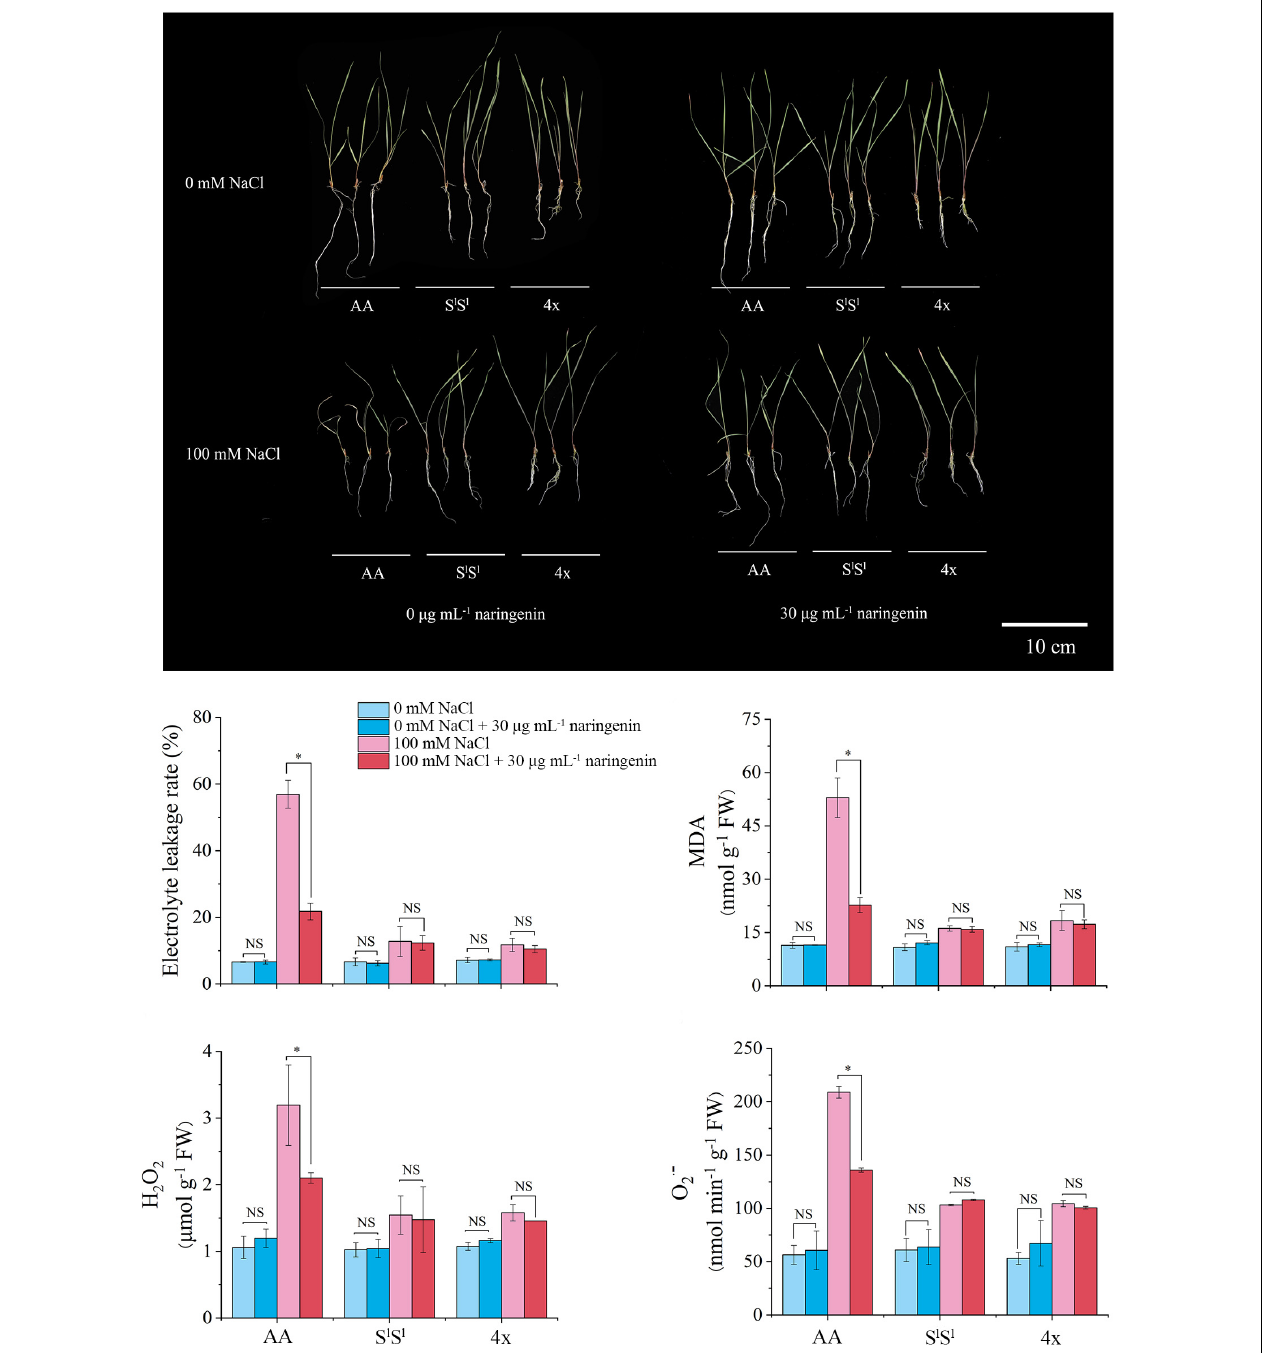
FIGURE 10 | Alleviative effects of exogenous naringenin application on salinity stress-induced injury. The naringenin of 30 µ g/mL was added into half-strength Hoagland nutrient solution with 100 mM NaCl or without NaCl. The seedlings were exposed to NaCl treatment for 10 days. The values are the mean ( ± SD) of three biological replicates. Star indicates significant differences between treatment with naringenin and treatment without naringenin and NS indicates no significant difference, according to t -test ( P <